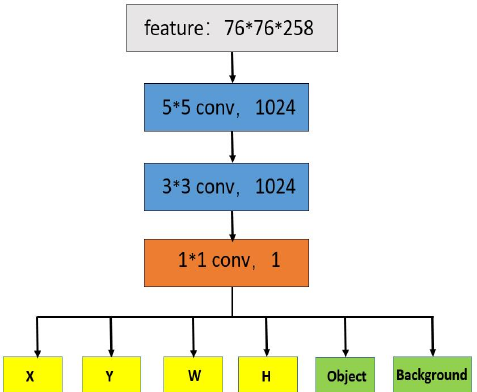
Figure 3. Structure parameters of anchor adjustment and background prediction module.